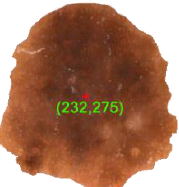
Figure 9. Center point detection of a segmented lesion .